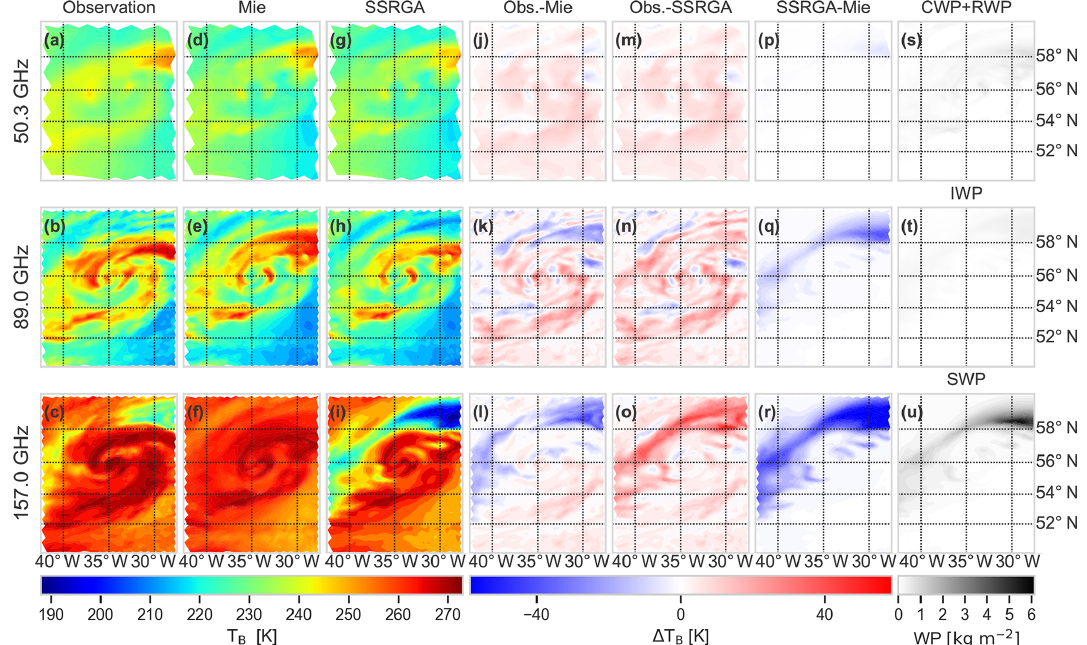
Figure 2. Observations with AMSU-A at 50.3GHz (a) as well as MHS at 89.0 (b) and 157.0GHz (c) for ex-tropical cyclone Karl on 26 September 2016 during the NAWDEX campaign over the North Atlantic; simulations with IFS and PAMTRA with single-scattering properties calculated with Mie theory (d–f) and simulations with SSRGA for ice and snow (g–i) . Difference in T B for Obs-Mie (j–l) , Obs- SSRGA (m–o) , and SSRGA-Mie (p–r) . Integrated contents as the sum of cloud water and rainwater path (CWP+RWP) (s) , ice water path (IWP) (t) , and snow water path (SWP) (u)